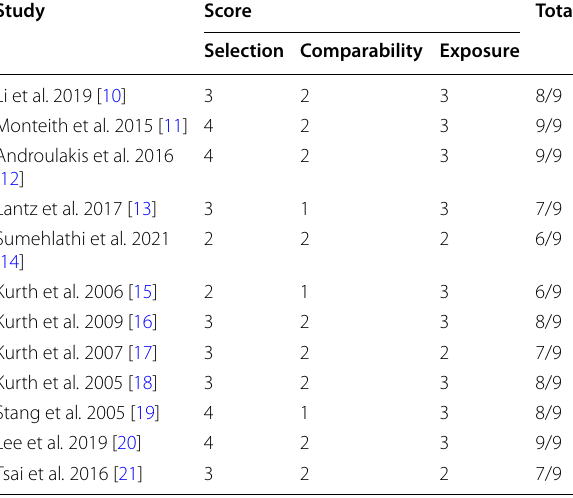
Table 1 Newcastle–Ottawa Quality Assessment Scale (NOS)